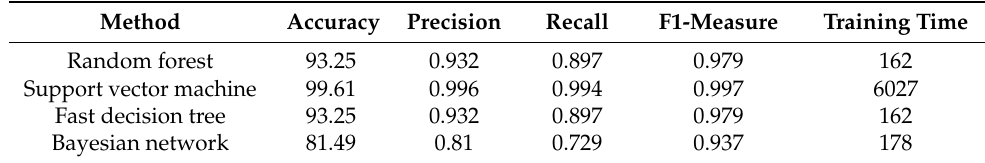
Table 3. Experimental results using the GoogleNet features with different classifiers.